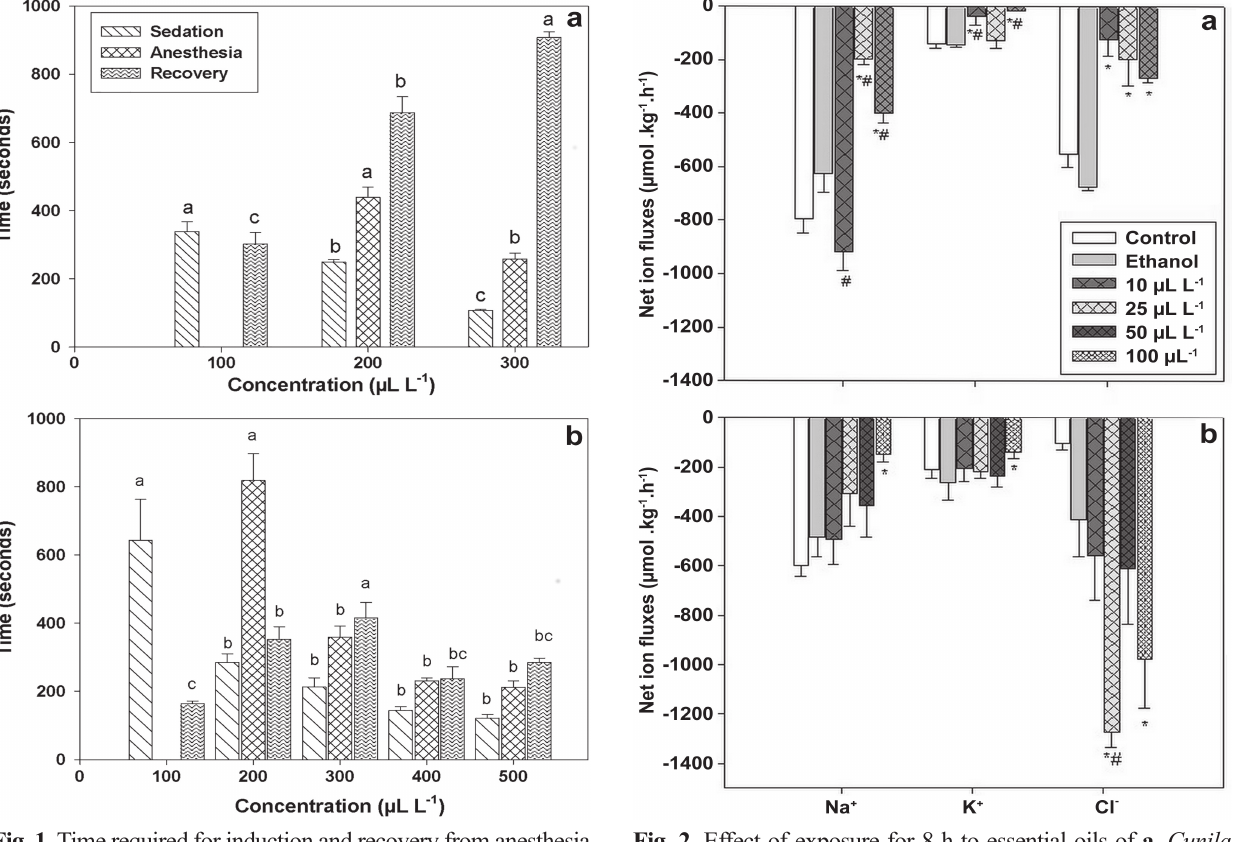
Fig. 1 . Time required for induction and recovery from anesthesia Fig. 2 . Effect of exposure for 8 h to essential oils of a. Cunila in Rhamdia quelen exposed to the essential oil of a. Cunila galioides and b. Origanum majorana on net Na + , K + and Cl - galioides and b. Origanum majorana . Statistics was performed fluxes in Rhamdia quelen . Statistics was performed through one- by one-way ANOVA followed by Tukey’s test to assess sedation way ANOVA followed by Tukey test; n=9; p <0.05. Results are and anesthesia induction times. For recovery (nonparametric expressed as the mean ± SEM. (*) indicates significant difference data) was performed Kruskal-Wallis test; n=9; p <0.05. Results are from control group; (#) indicates significant difference from expressed as the mean ± SEM. Different letters indicate statistical ethanol group. There are no data for 100 µL L -1 EOC because all difference between concentrations measured in the same stage. fish died within 2 h of exposure. Tab. 1 . Effect of the essential oil of Cunila galioides (EOC) and Origanum majorana (EOO) on ventilatory rate in Rhamdia quelen . Statistics was performed through the Scherer-Ray-Hare extension of the Kruskal-Wallis test followed by the Nemenyi test; n=9; p <0.05. Results are expressed as the mean ± SEM. The fish exposed to 100 μL L -1 EOC died within 2h of exposure. Lowercase letters indicate significant difference between times in the same group; capital letters indicate significant difference between groups at the same time. Time